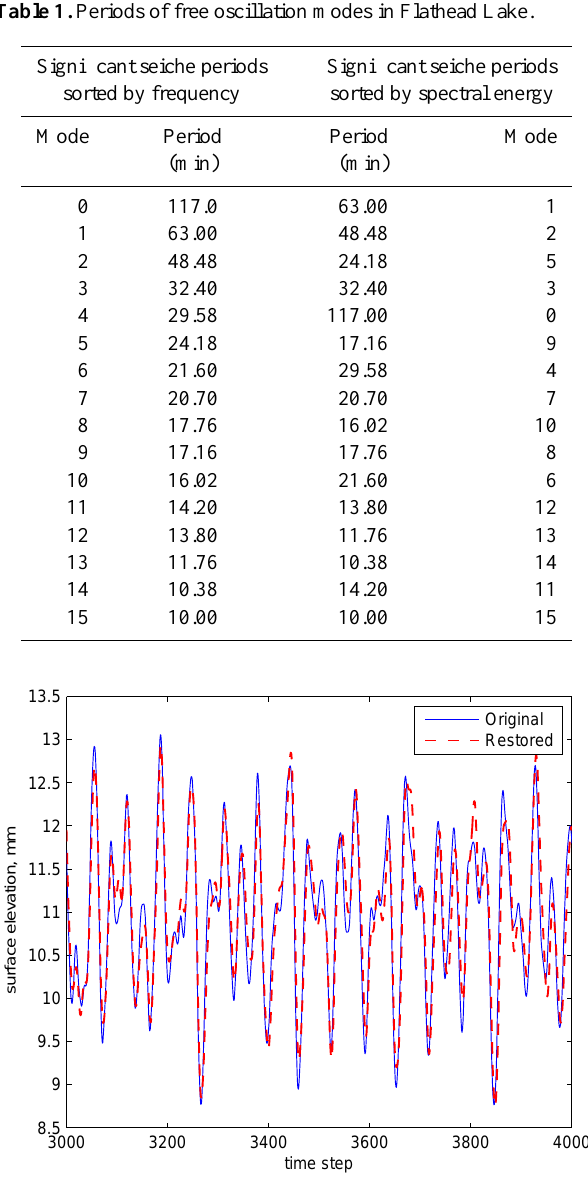
Figure 3. Lake surface oscillations at a single point in the middle of the lake produced by the model (blue solid line) and restored from the 12 harmonics (modes) of the Fourier analysis (red dashed line).